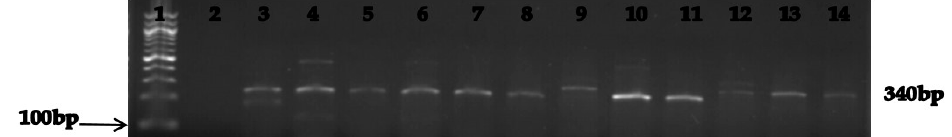
Figure 6. PCR products of the amplification of bla KPC gene. Lane1: 100 bp molecular weight marker; Lane 2: negative control; Lanes 3–14: positive isolates.